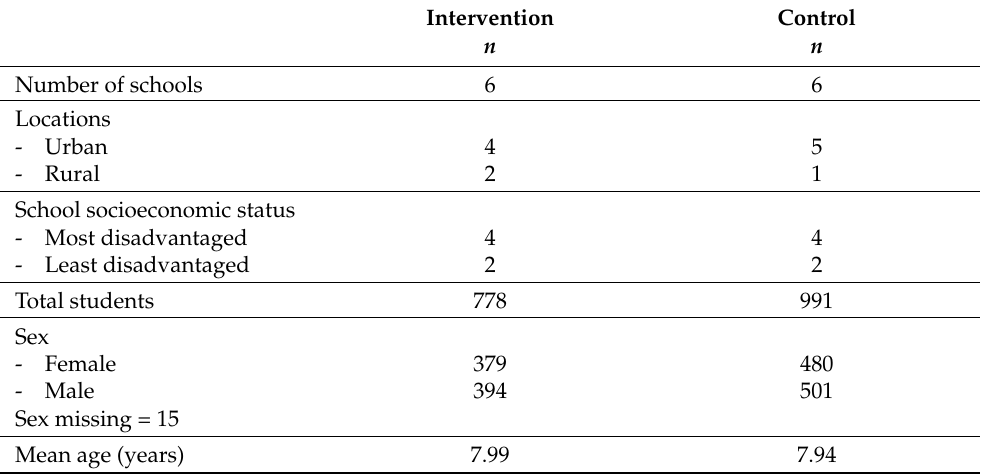
Table 2. Sample characteristics of schools and students at baseline.